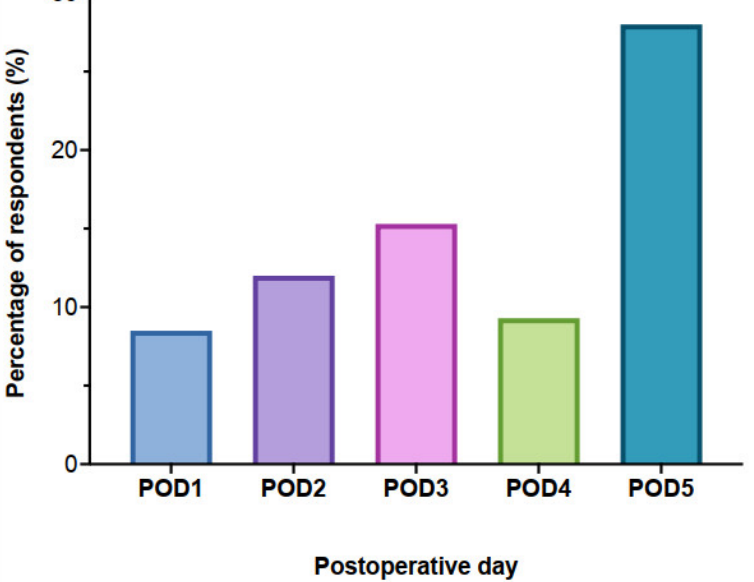
Figure 2. Timing of vitamin K antagonist initiation after cardiac surgery. POD: postoperative day